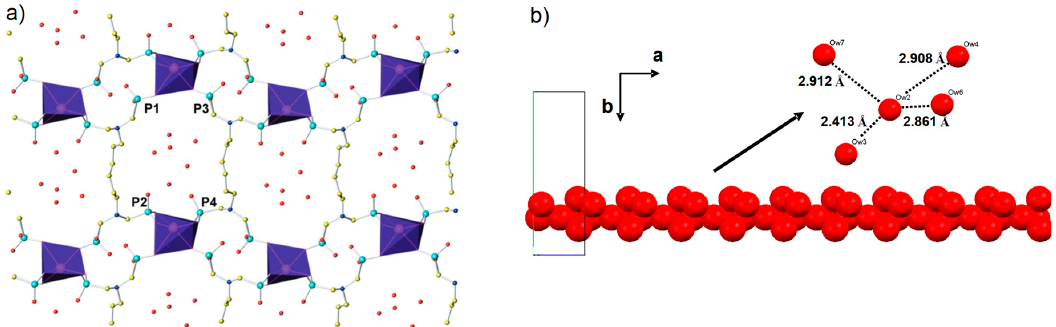
Figure 30. ( a ) Crystal structure of La(H 5 DTMP)·7H 2 O and ( b ) the extended network of hydrogen-bonded water molecules along the a -axis, along with a detail of the hydrogen bonding distances. Colour code: lanthanum: purple, phosphorus: light blue, oxygen: red, nitrogen: dark blue, carbon: yellow. Adapted with permission from reference [129]. Copyright 2012, Royal Society of Chemistry.